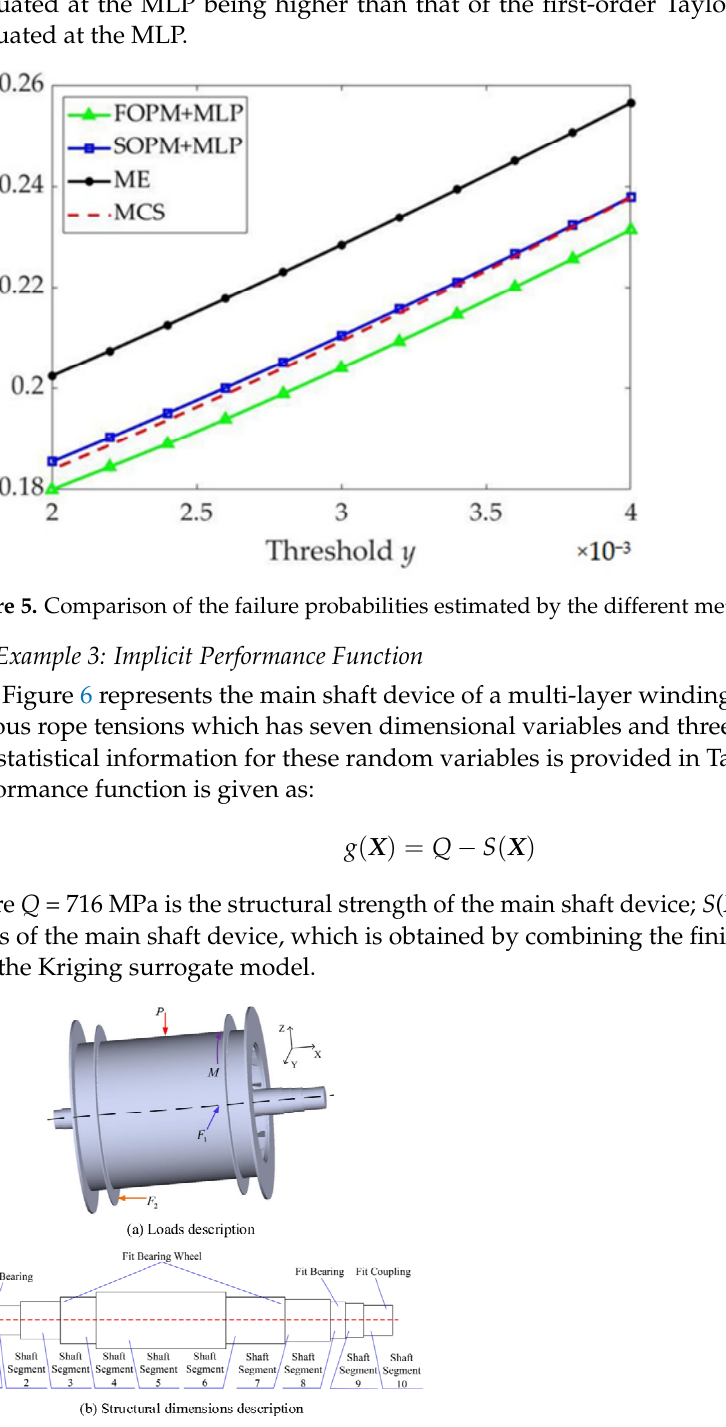
Figure 6. Main shaft device of a multi ‐ layer winding mine hoist for Example 3.